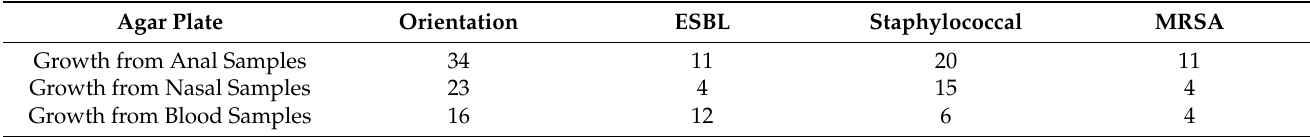
Table 4. Counts of antibiotic-resistant bacteria from the different sample sites. Agar Plate Orientation